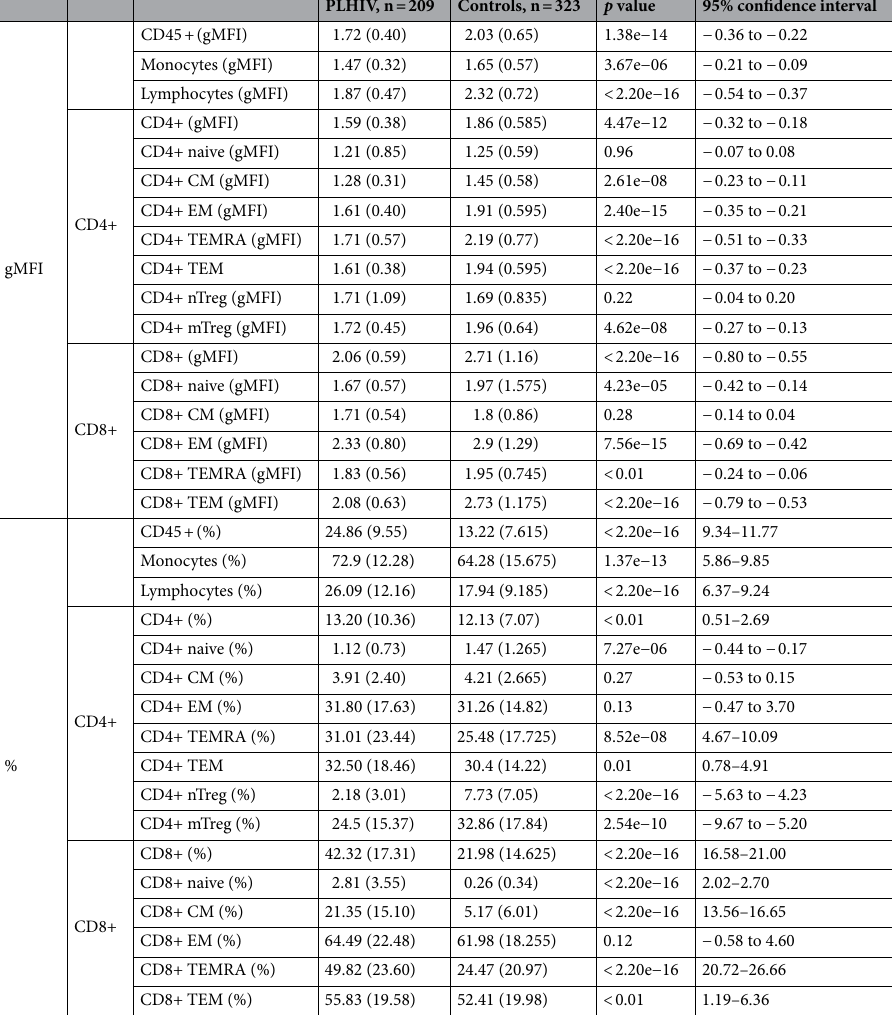
Table 2. CCR5 expression levels (%CCR5+ cells and MFI) in PLHIV and controls. The unadjusted p values are derived from comparisons between the groups by Mann–Whitney U test. Data were summarized as medians and IQR. PLHIV = people living with HIV, CM T cells = central memory T cells, EM T cells = effector memory T cells, TEMRA cells = T effector memory cells expressing CD45RA, nTreg = naïve regulatory T cells, mTreg = memory regulatory T